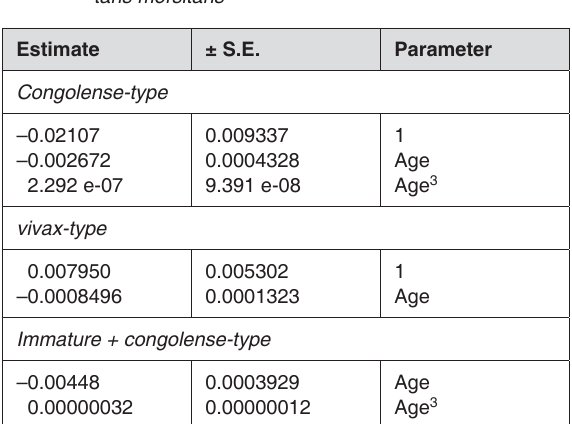
TABLE 2 Parameter estimates of age-prevalence models for three trypanosomal infection-types in female G. morsi-